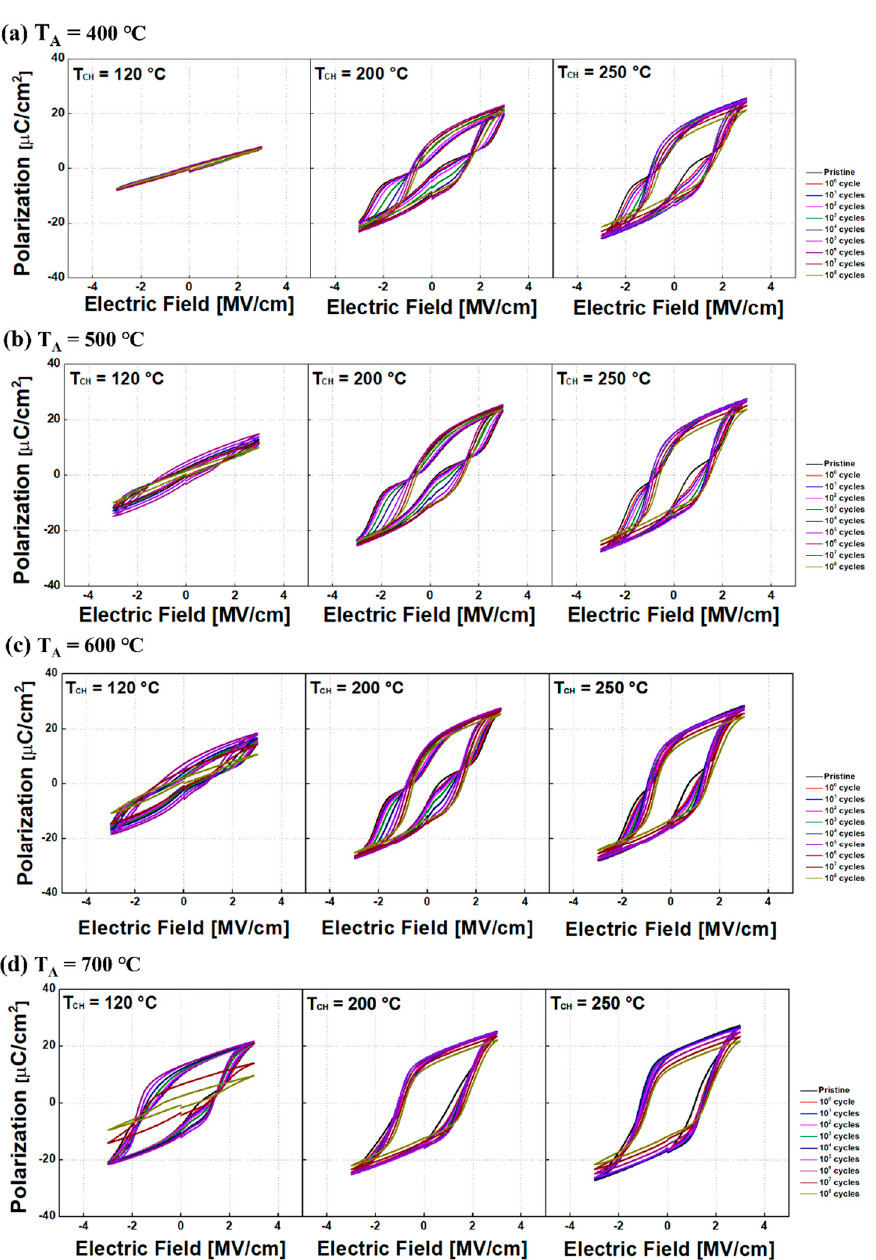
Figure 7. Measured polarization vs. electric field (PE) characteristics of TiN/HZO/TiN capacitors fabricated at various chamber temperatures (i.e., 120 °C, 200 °C, and 250 °C) as well as at various annealing temperatures (T A ): ( a ) 400 °C, ( b ) 500 °C, ( c ) 600 °C, and ( d ) 700 °C. Note that the different numbers of cycles were used to explore the endurance characteristics of the ferroelectric capacitor.